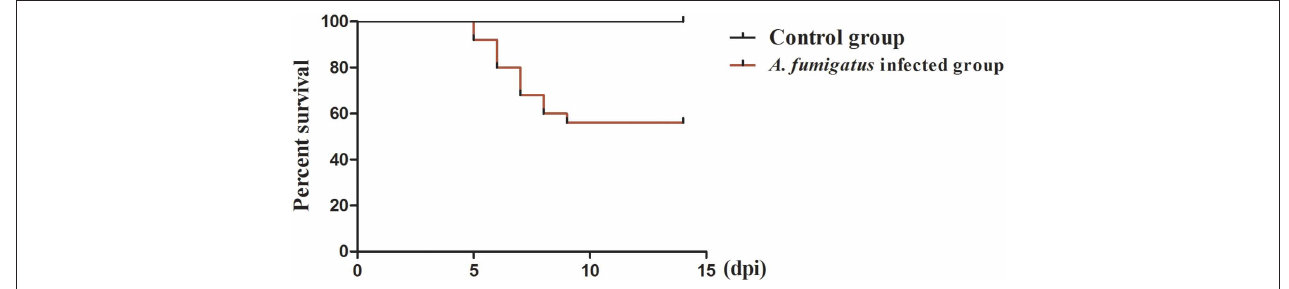
FIGURE 1 | Survival curve after infection with Aspergillus fumigatus . Infected chicken was infected with 2 × 10 6 CFU condia via intra-right thoracic air sac. Control chicken was inoculated with 0.1ml PBS via the same route. In the Aspergillus fumigatus infected group, a total of 11 chickens died from 5 to 9 dpi, respectively. No chickens died in the control group throughout the experiment.